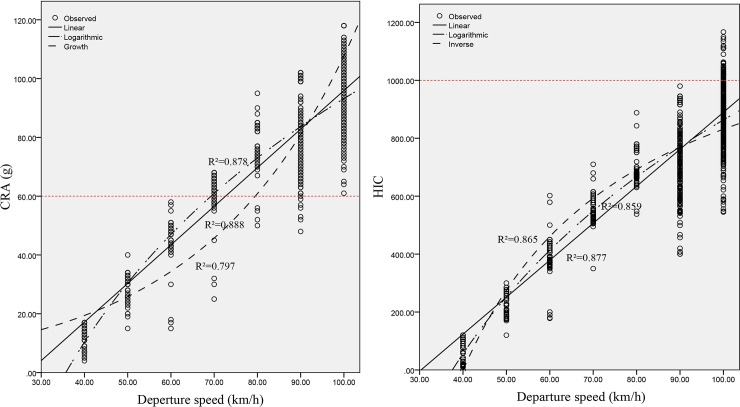
Relationship between the CRA, HIC and departure speed.